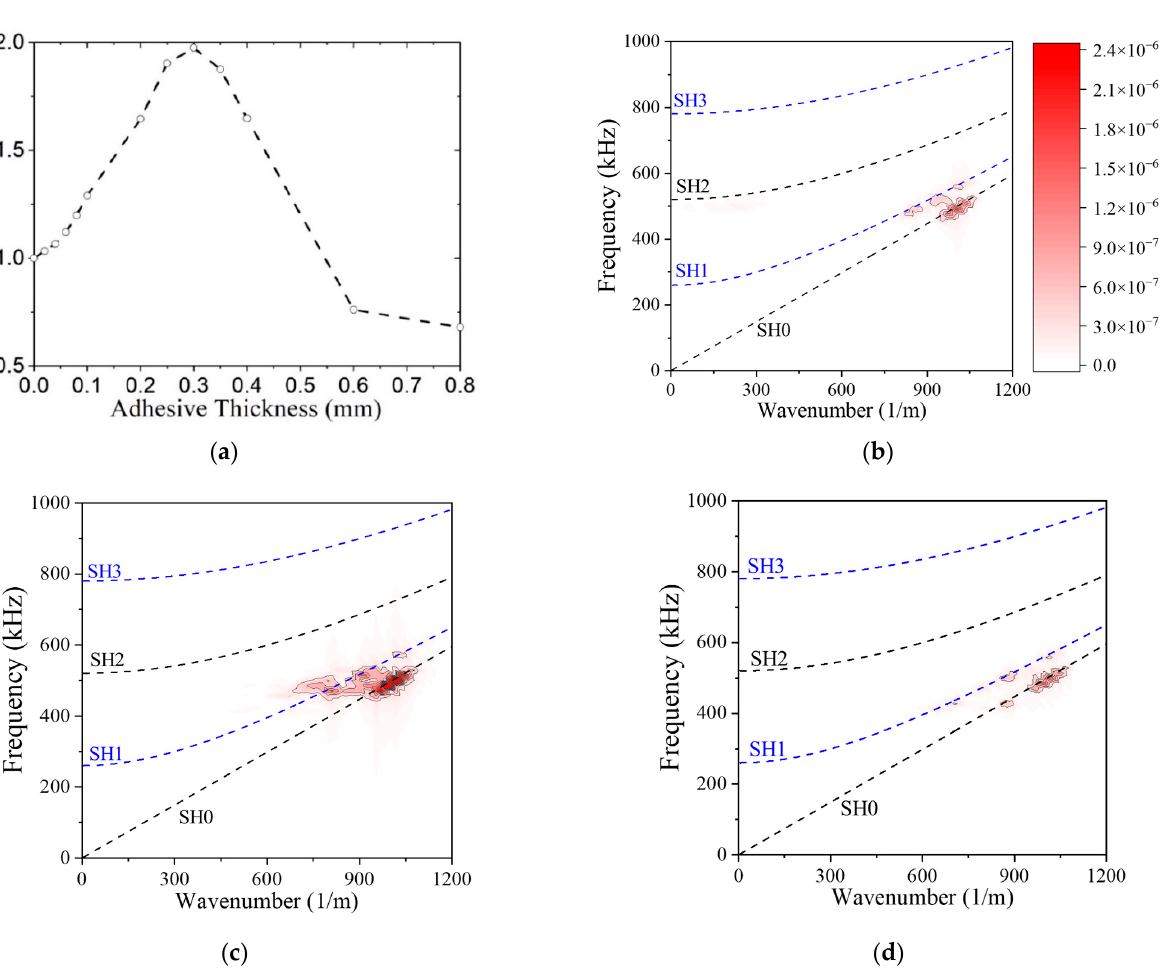
Figure 9. Effect of the adhesive thickness on SH0 wave amplitude and wave modes, ( a ) normalized wave amplitude as a function of adhesive thickness. Wavenumber spectra for MST with adhesive thickness of ( b ) 0.0 mm; ( c ) 0.3 mm; ( d ) 0.6 mm. ( b , c ) and ( d ) have the same color bar.